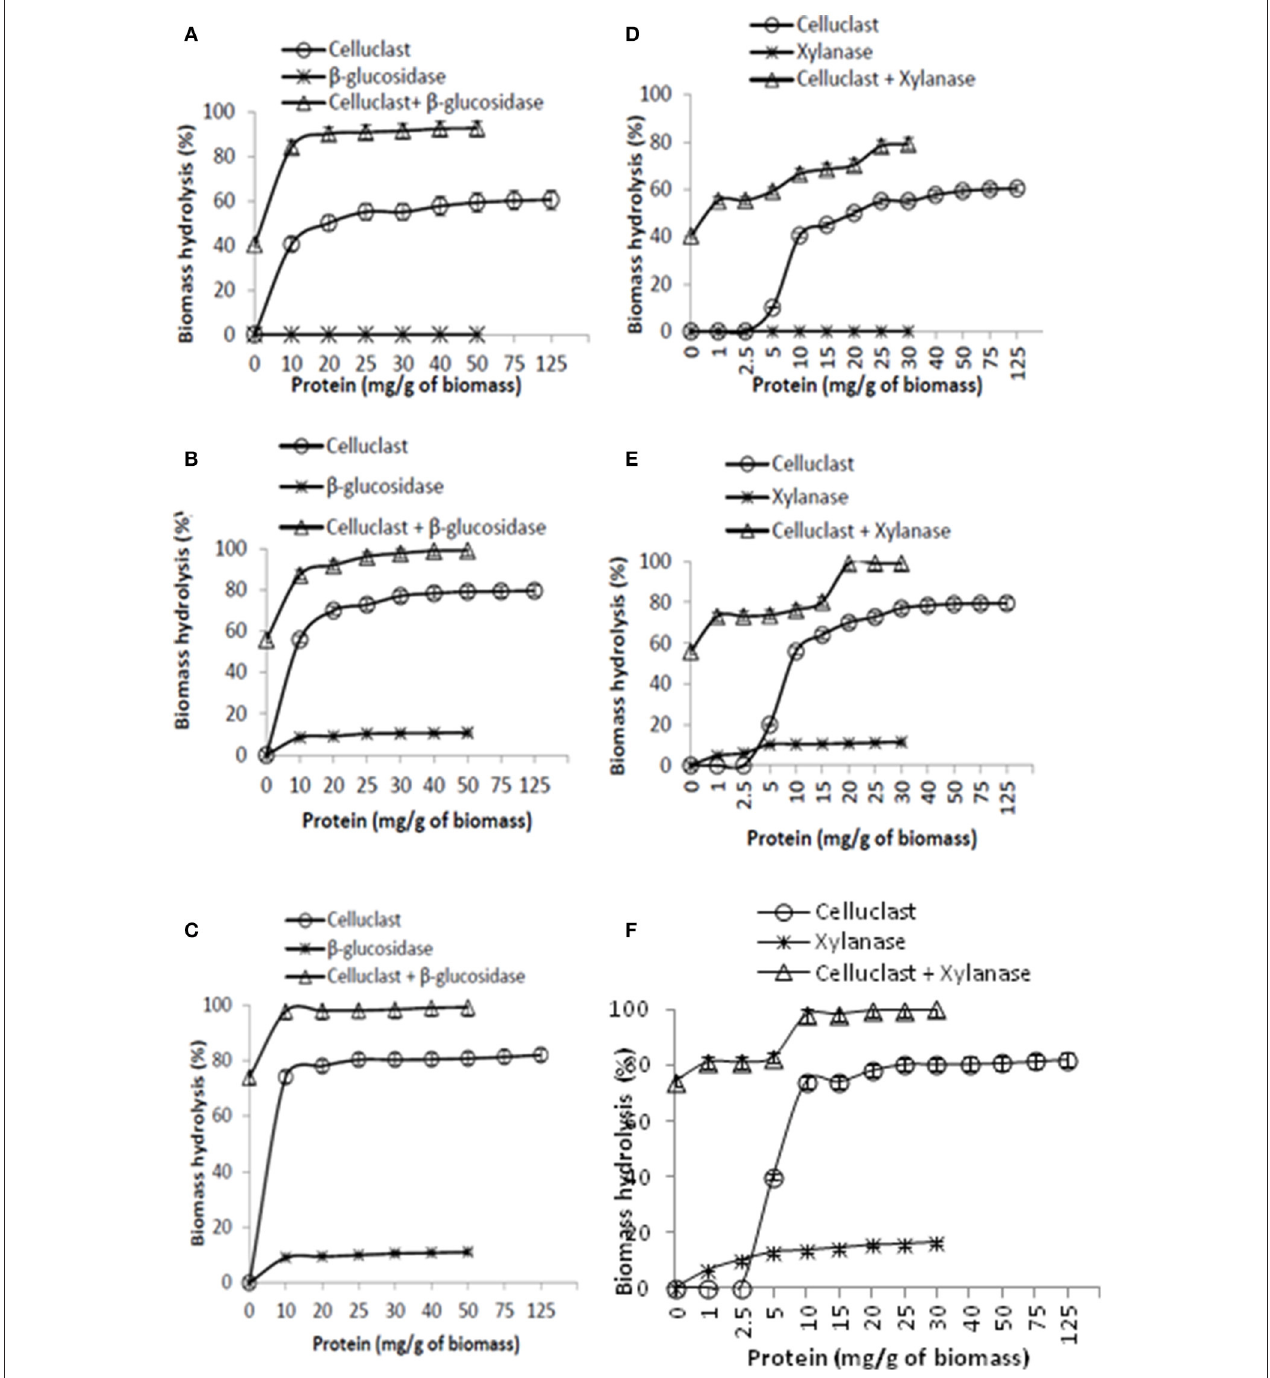
FIGURE 2 | Supplementation of Celluclast with β -glucosidase (A–C) and xylanase (D–F) . The corresponding hydrolysis time for (A,D) , (B,E) , and (C,F) is 6, 24, and 48h, respectively.